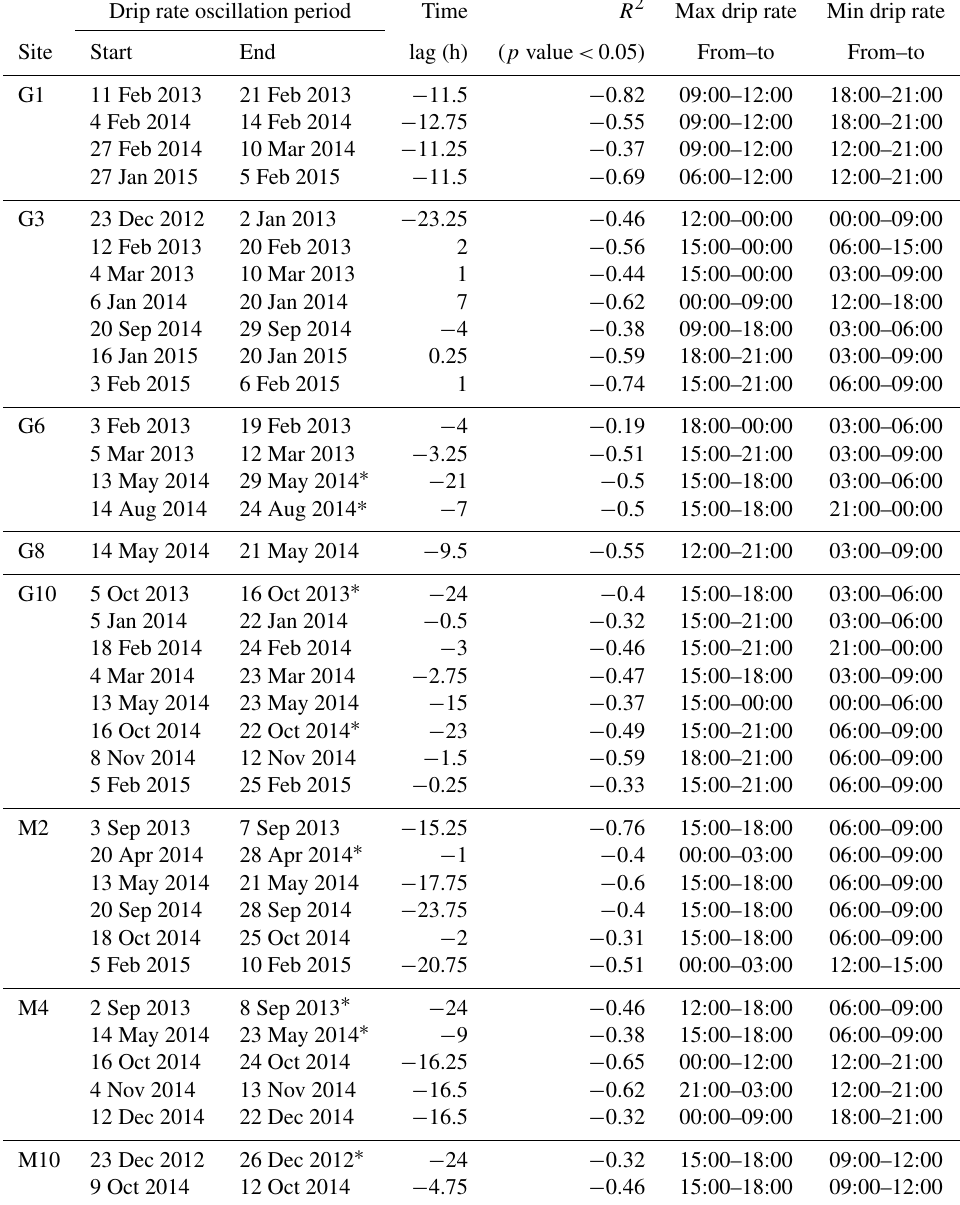
Table 2. The time lag calculated using cross correlation analysis between air temperature and daily drip rate for each period of drip rate oscillation; the timing of when minimum and maximum drip rate occurred within the time periods ∗ denote periods where a 2cpd signal occurs. A negative time lag means the minimum drip rate lags behind the peak temperature whereas a positive lag means the minimum drip rate precedes the maximum